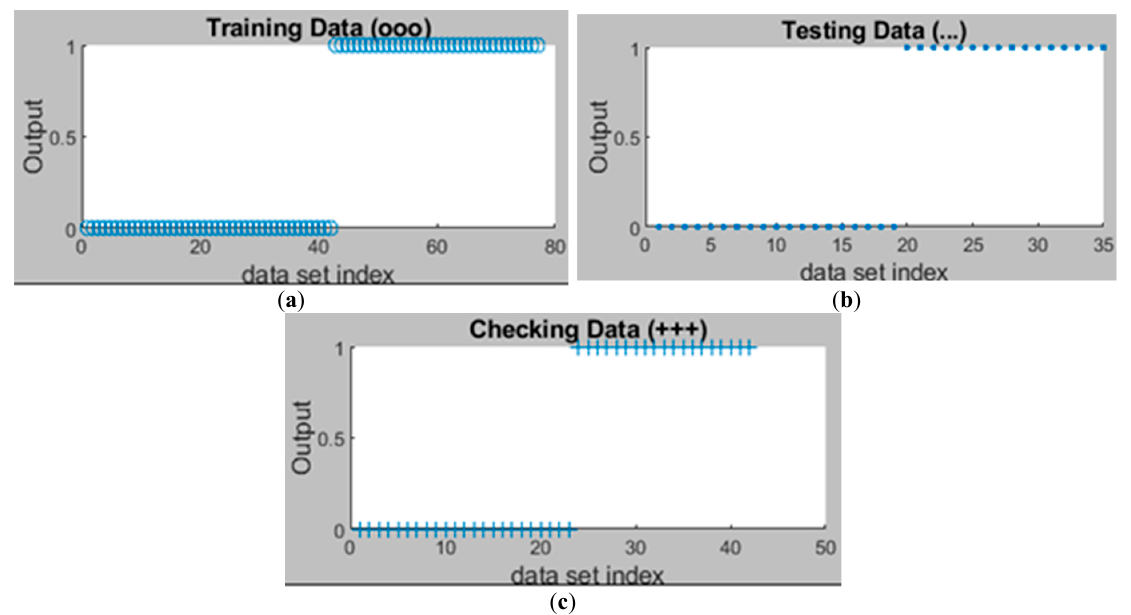
Figure 23. Data ‐ set index for ( a ) training, ( b ) testing and ( c ) checking, respectively. Figure 23. Data-set index for ( a ) training, ( b ) testing and ( c ) checking, respectively. Figure 23. Data-set index for ( a ) training, ( b ) testing and ( c ) checking, respectively. Figure 23. Data-set index for ( a ) training, ( b ) testing and ( c ) checking, respectively.